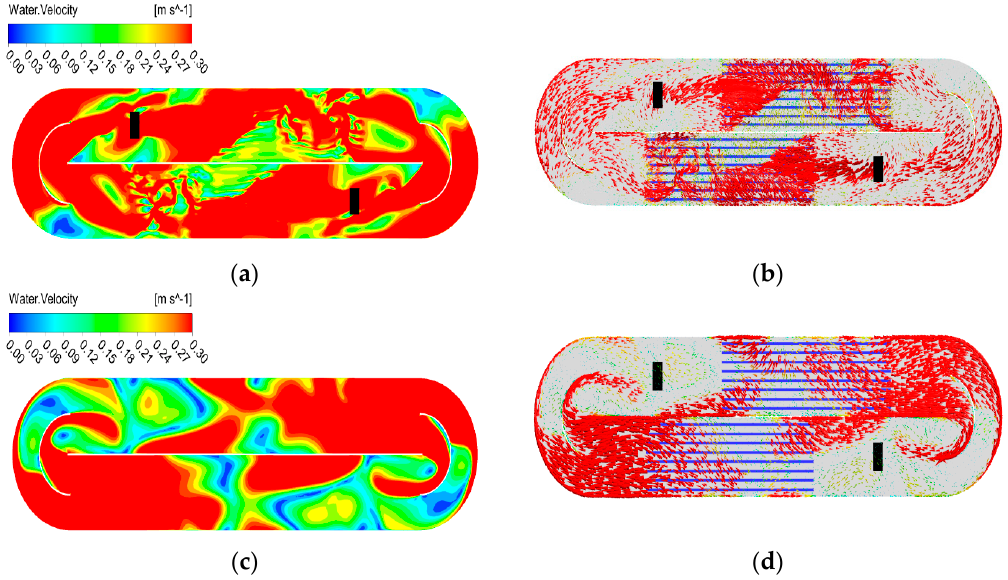
Figure 4. Water velocity contour ( a, c ) and its vectorial representation ( b, d ) on a horizontal plane at 0.5 m and 6 m (from top to bottom) above the tank floor.